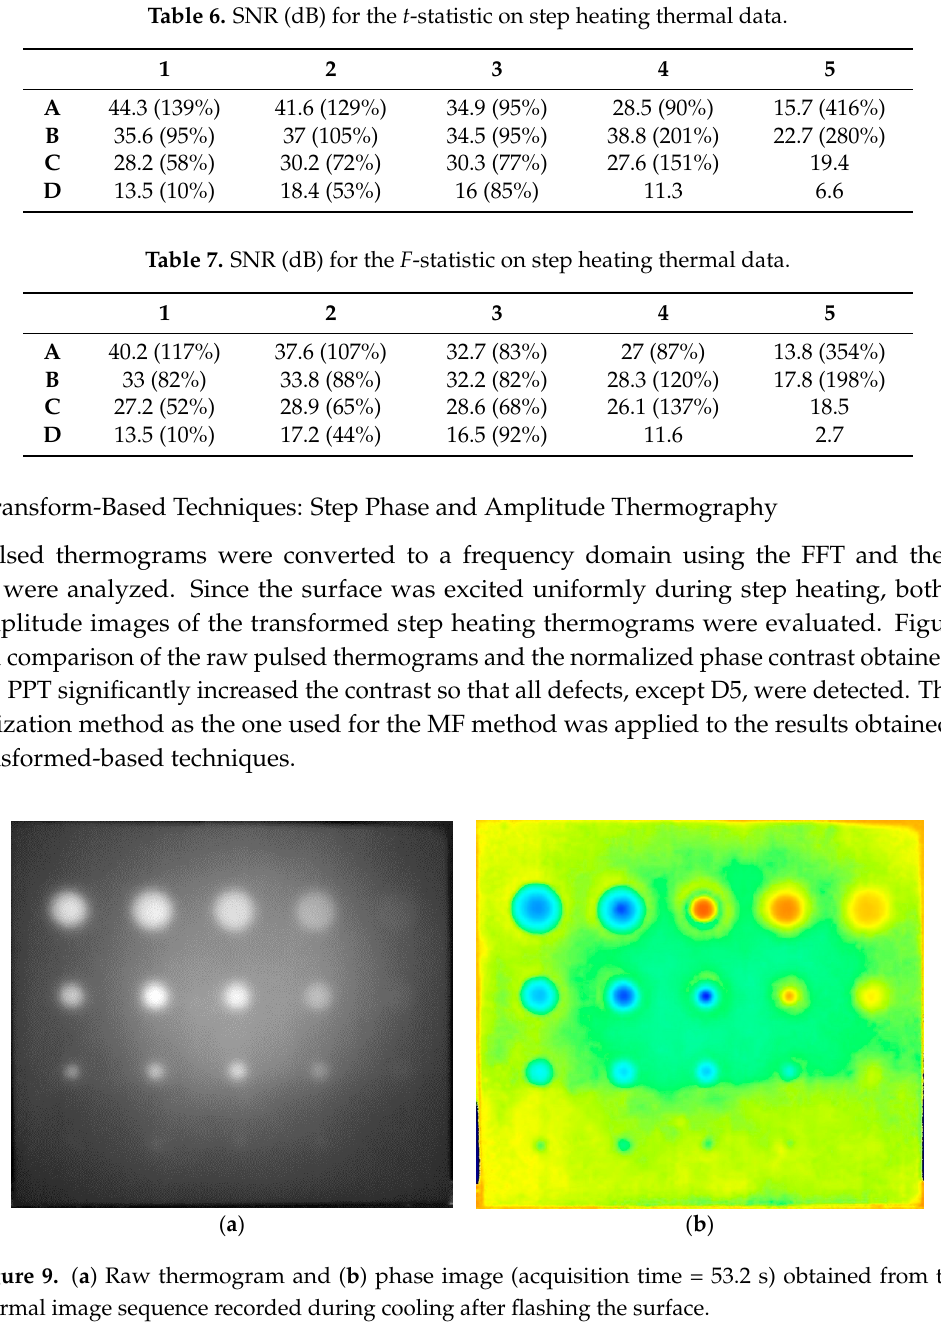
Table 6. SNR (dB) for the t -statistic on step heating thermal data.